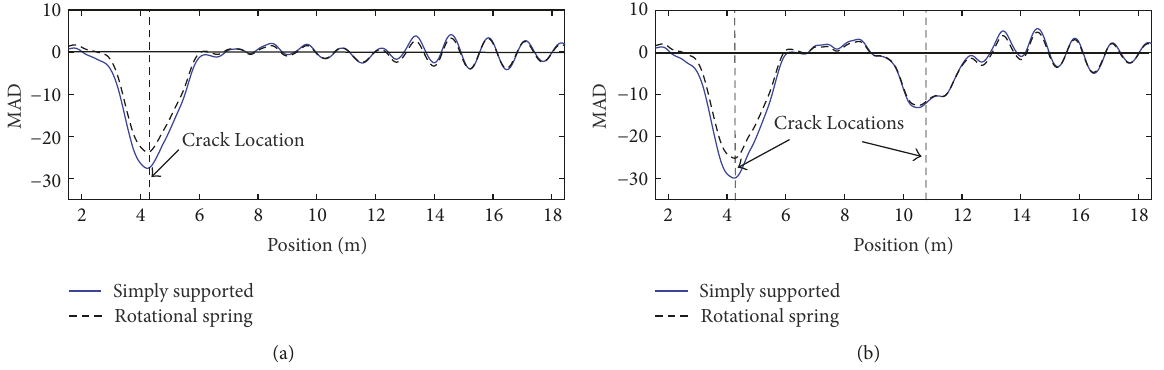
Figure 12: MAD for the bridge with and without a rotational spring: (a) the first damage case and (b) the second damage case.